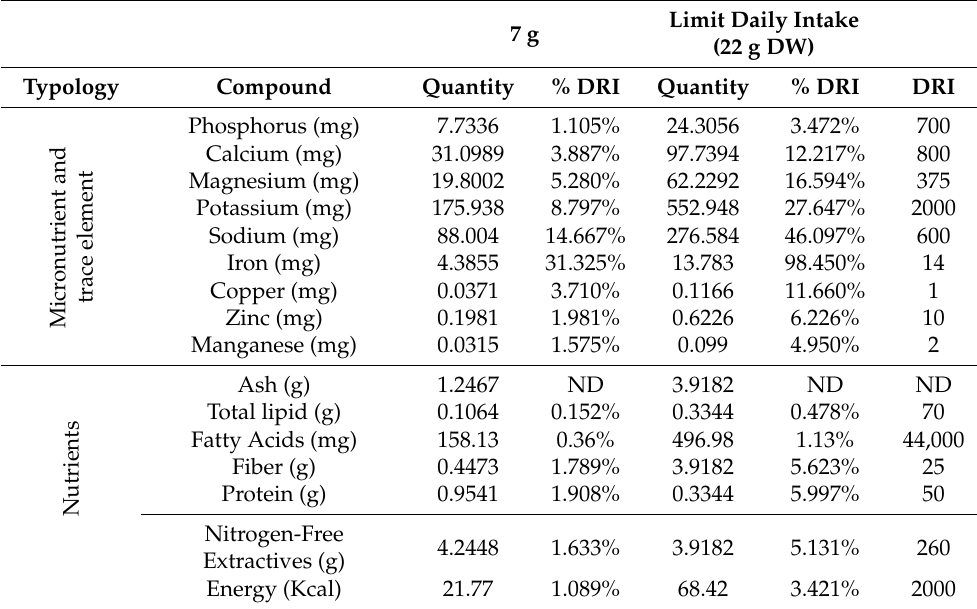
Table 13. Nutritional value in 7 g of S. latissima according to the established Dietary Reference Intake (DRI) and its food intake limit using the DRI [5,9]. ND—not determined. 7